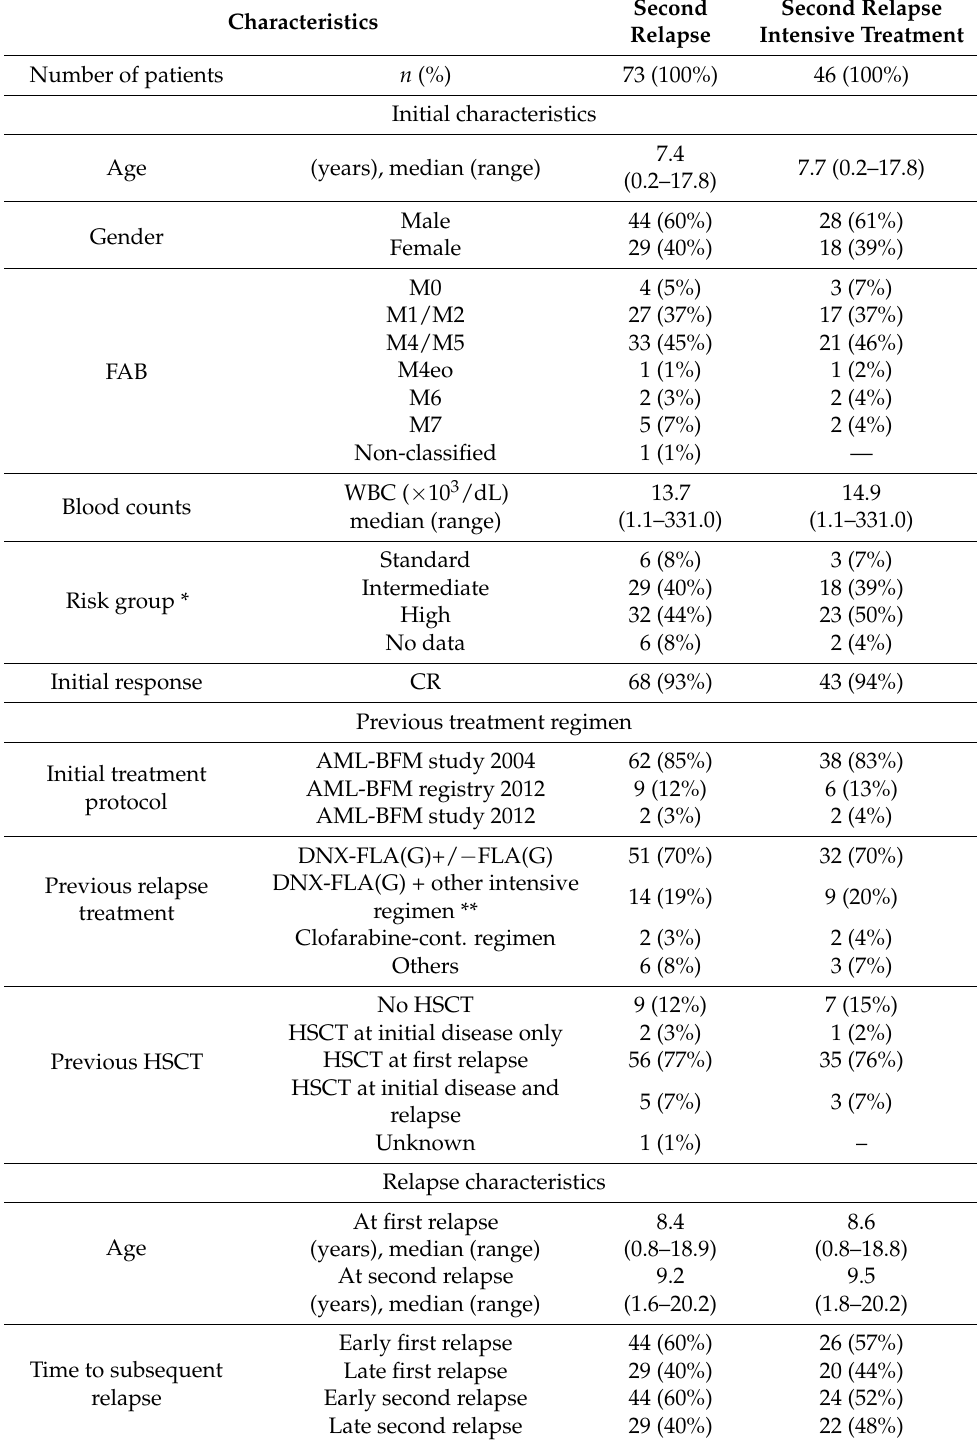
Table 1. Baseline